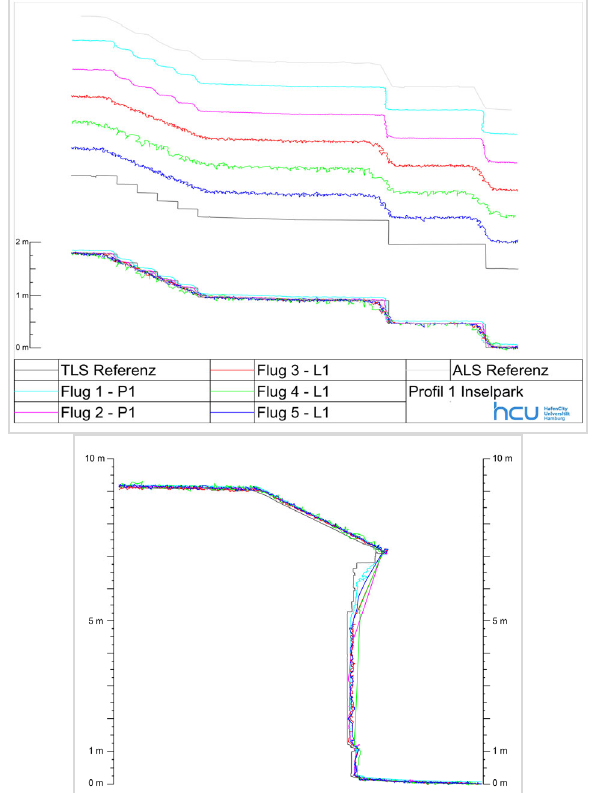
Figure 9 . Comparison of profile 2 created from different point clouds with reference data from terrestrial laser